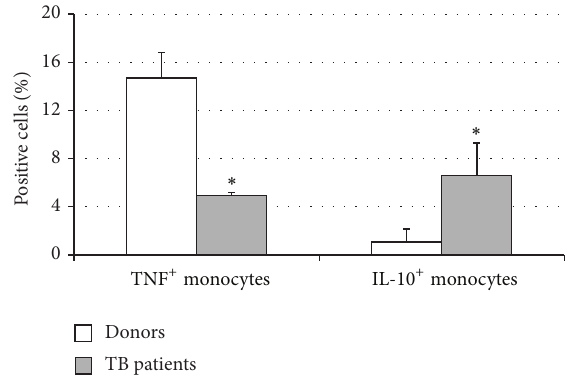
Figure 2: The spontaneous intracellular expression of TNF- 𝛼 and IL-10 in donor ( 𝑛 = 8 ) and TB patient ( 𝑛 = 8 ) circulating CD14 + monocytes. The data are presented as M ± S.E. ∗ 𝑃 𝑈 < 0.05 (Mann- Whitney U -criterion) between healthy donors and TB